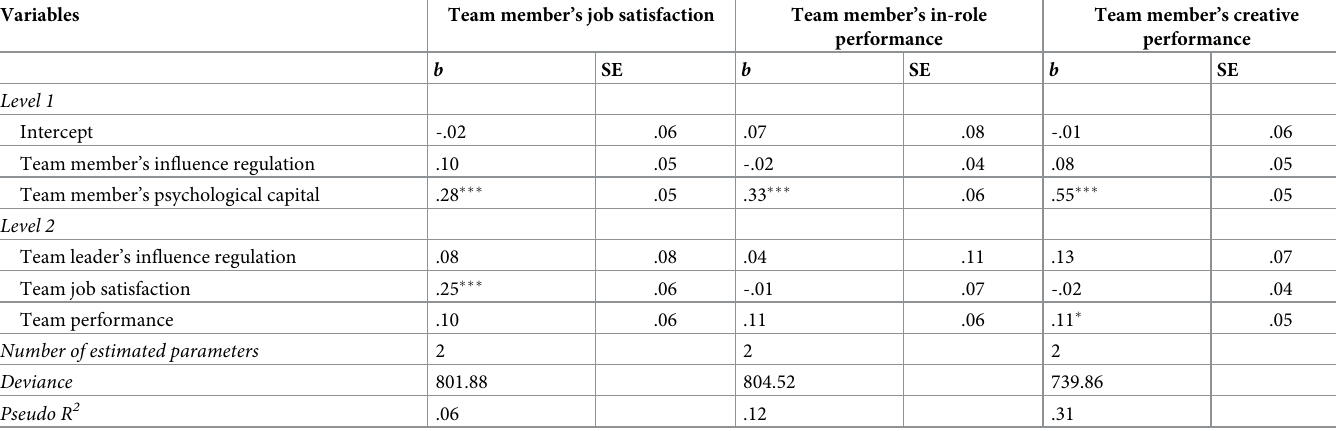
Table 2. Results of multilevel analyses predicting team member’s job satisfaction and job